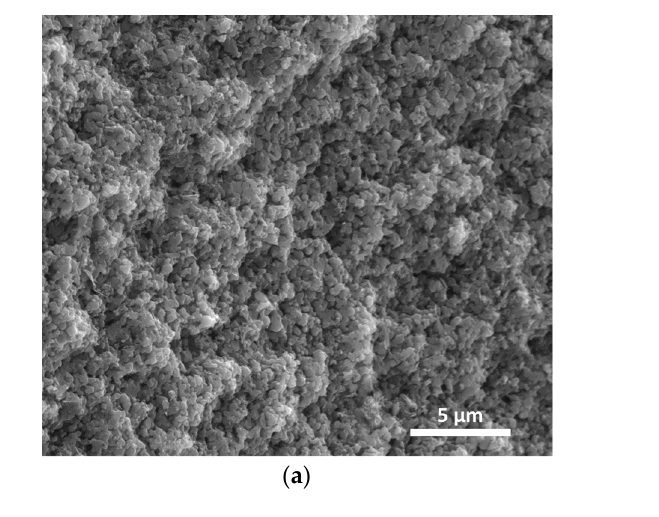
Figure 4. SEM images of MC materials obtained from the carbonization of RF resin (EISA approach) showing the morphology and structure of these materials. ( a ) 5000× magnification image showing carbon aggregates; ( b ) 50,000× magnification image featuring meso- and macropores in the structure. Table 2. Textural properties of the mesoporous carbons synthesized using the soft templated organic- organic self-assembly of resorcinol and formaldehyde in the presence of various